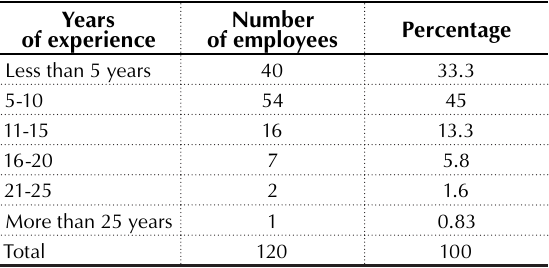
Table 3. Frequency distribution of the study